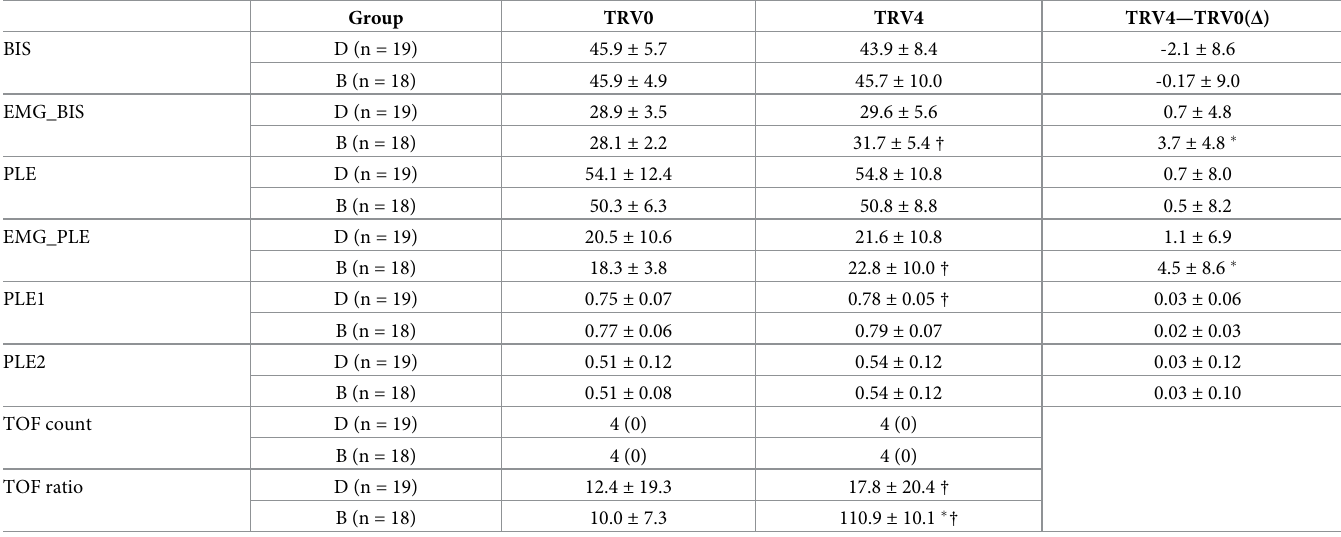
Table 9. Changes in BIS and PLE of patients in general